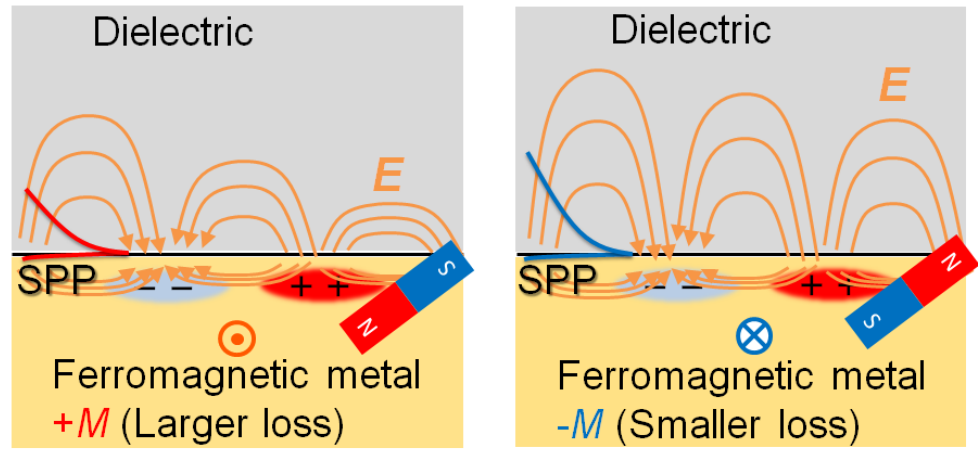
Figure 3. Illustrative representation for the active tuning of insertion losses in a magnetoplasmonic